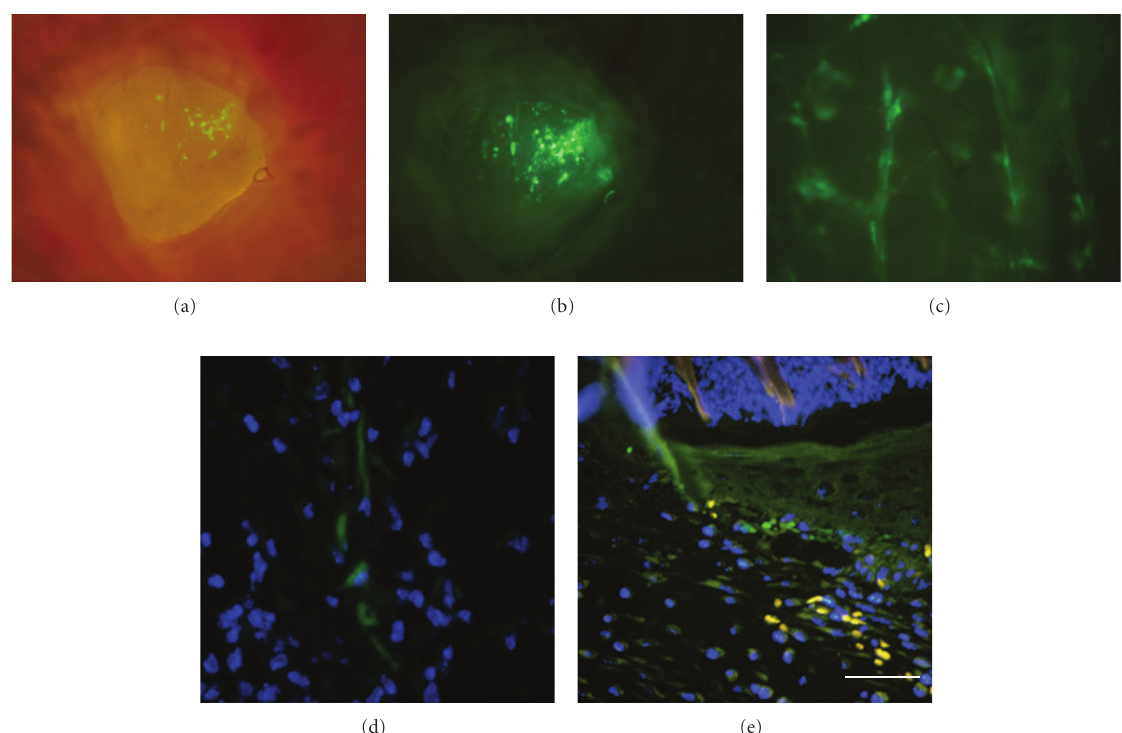
Figure 4: Analysis of the wound area. Gross examination under fluorescence microscope of wounds 5 days after administration of GFP- labelled cells. Original magnification 10X (a) and (b) and 40X (c). Anti GFP immunohistochemistry at the lesion site 2 (d) and 5 days